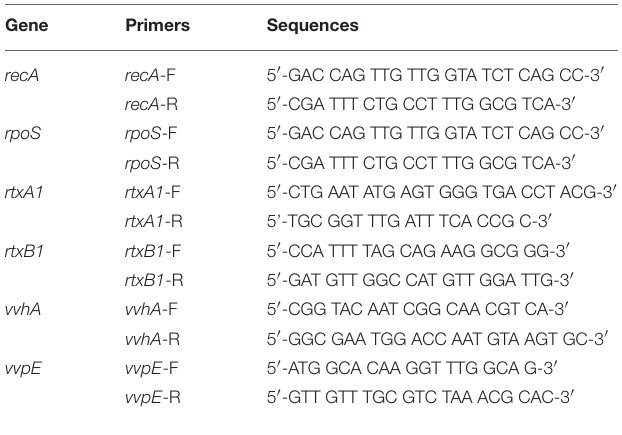
TABLE 2 | Primers used in real-time PCR